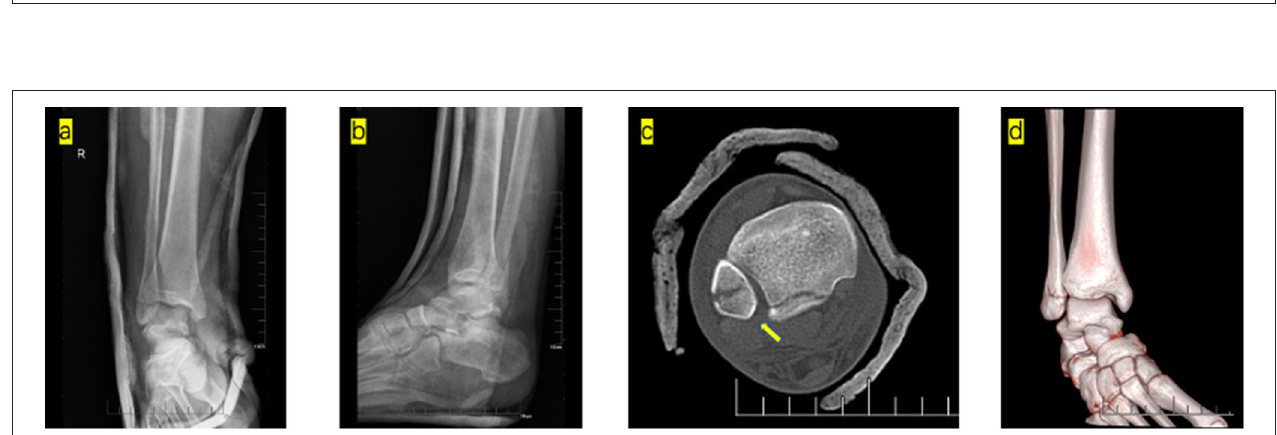
FIGURE 1 | First attempted closed reduction of images: (a) Anteroposterior radiograph shows medial malleolus the axilla sign (yellow arrow). (b) Lateral radiograph show posterior subluxation of the talus. Axial CT scan (c) showing that the proximal fragment of the fibula was locked between the anterior part of the fibular notch and the posterior tibial fragment (yellow arrow). CT soft tissue reconstruction showing posterior tibial tendon (d) (yellow arrow) and flexor hallucis longus (d) (red arrow) located in the anatomical position.